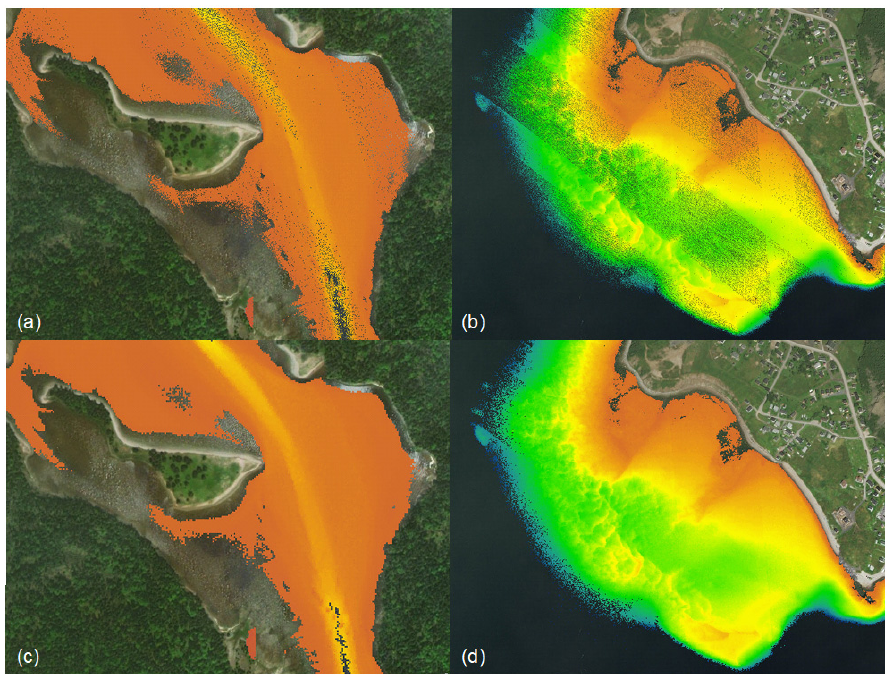
Figure 5. ( a ) and ( b ) show 1 m elevation data for S2–S3 datasets, while ( c ) and ( d ) shows the same Figure 5. ( a , b ) show 1 m elevation data for S2–S3 datasets, while ( c , d ) shows the same data but data but gridded at 2 m to minimize data gaps. gridded at 2 m to minimize data